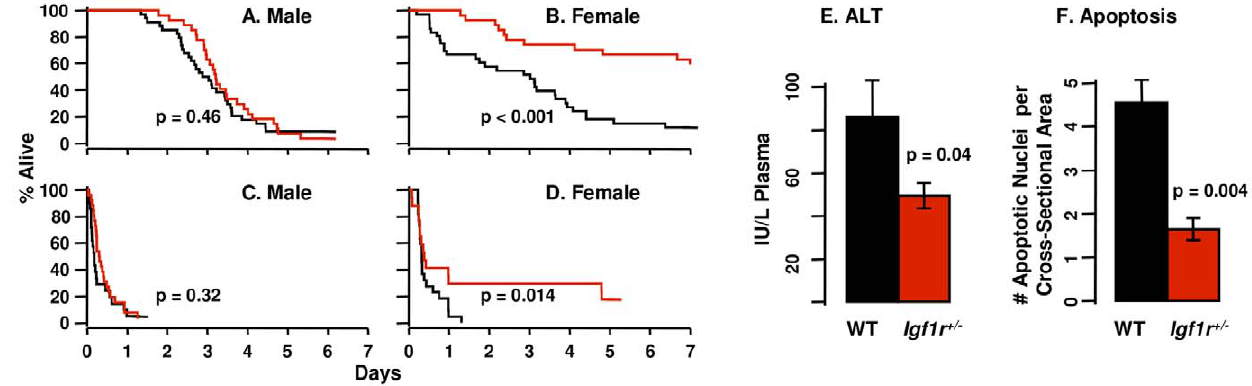
Figure 6. Sensitivity of WT and Igf1r + / 2 mice to oxidative stress. Paraquat (50 mg/kg) was administered to 37 male WT mice and 26 male Igf1r + / 2 mice (graph A) as well as to 39 female WT mice and 24 female Igf1r + / 2 mice (graph B). Diquat (50 mg/kg) was administered to 21 WT and 26 Igf1r + / 2 male mice (graph C) as well as to 22 WT and 17 Igf1r + / 2 female mice (graph D). The mice in graphs A–D were 5 to 9.5 months of age. Censored data points (due to uncertainty about the exact minute of an animal’s death) are indicated by vertical tick-marks. Graphs E and F: Female WT and Igf1r + / 2 mice (10 to 11 months of age) were treated with diquat (50 mg/kg). Six hours after treatment the mice were killed and the ALT activities in the plasma (graph E) and number of apoptotic cells per unit area in a liver cross section (graph F) of 7 WT and 8 Igf1r + / 2 mice were determined. The mean and SEM are shown in the bar graphs. Black represents WT data and red represents Igf1r + / 2 data. Survival data were analyzed using the log-rank test while the ALT and apoptosis data were analyzed using Student’s t-test and the p-values are shown.